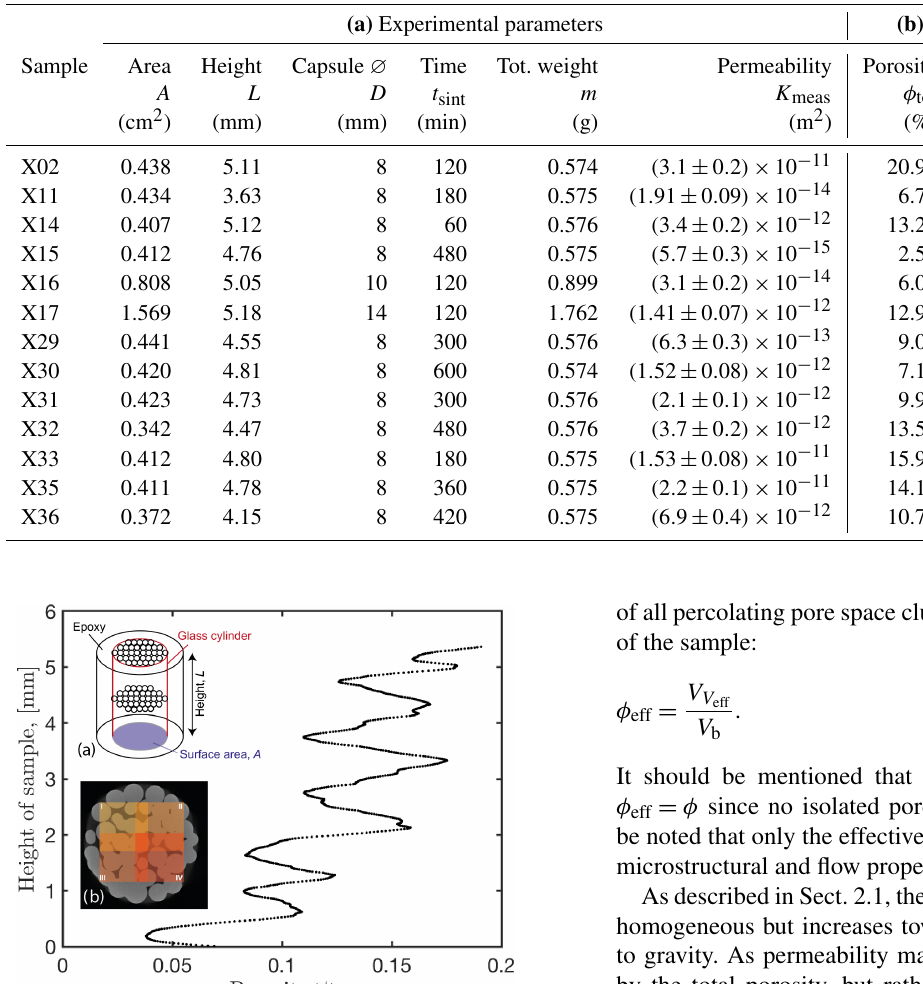
Table 1. Column (a) displays the experimental parameters of sintering conditions and parameters used to compute permeability using Darcy’s law. A denotes the sample surface area, L the height of the glass bead cylinders and D the inner diameter of each capsule. Additionally, the sintering time t sint , the total weight of the glass beads m and the experimentally measured permeability K meas are given. In (b) , we list the total, effective and minimum effective porosity – φ tot , φ eff and min (φ eff ) – of each sample. These porosities have been obtained with image processing (see Sect. 2.4).